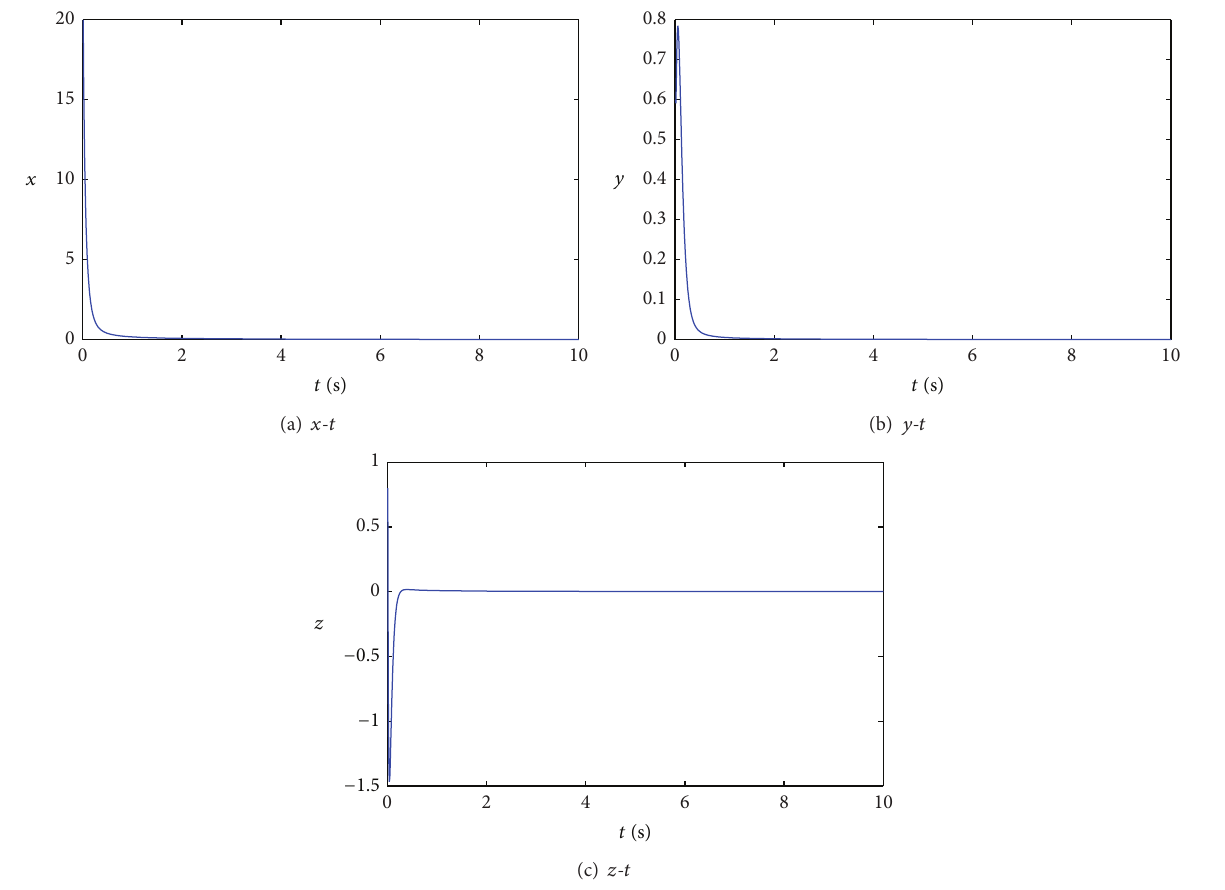
Figure 9: State trajectories of closed-loop system (5) with controller